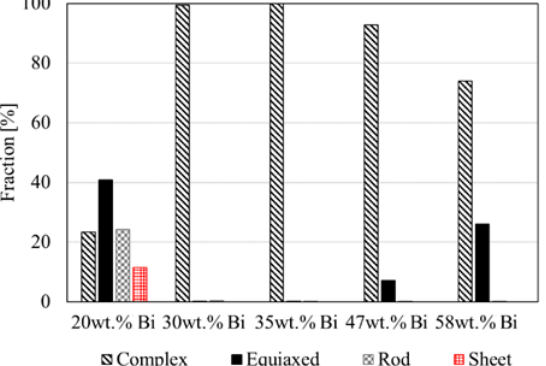
Figure 15. Figure 15. Volume fractions of morphology classes in Sn-Bi alloys obtained from segmented µ -XCT